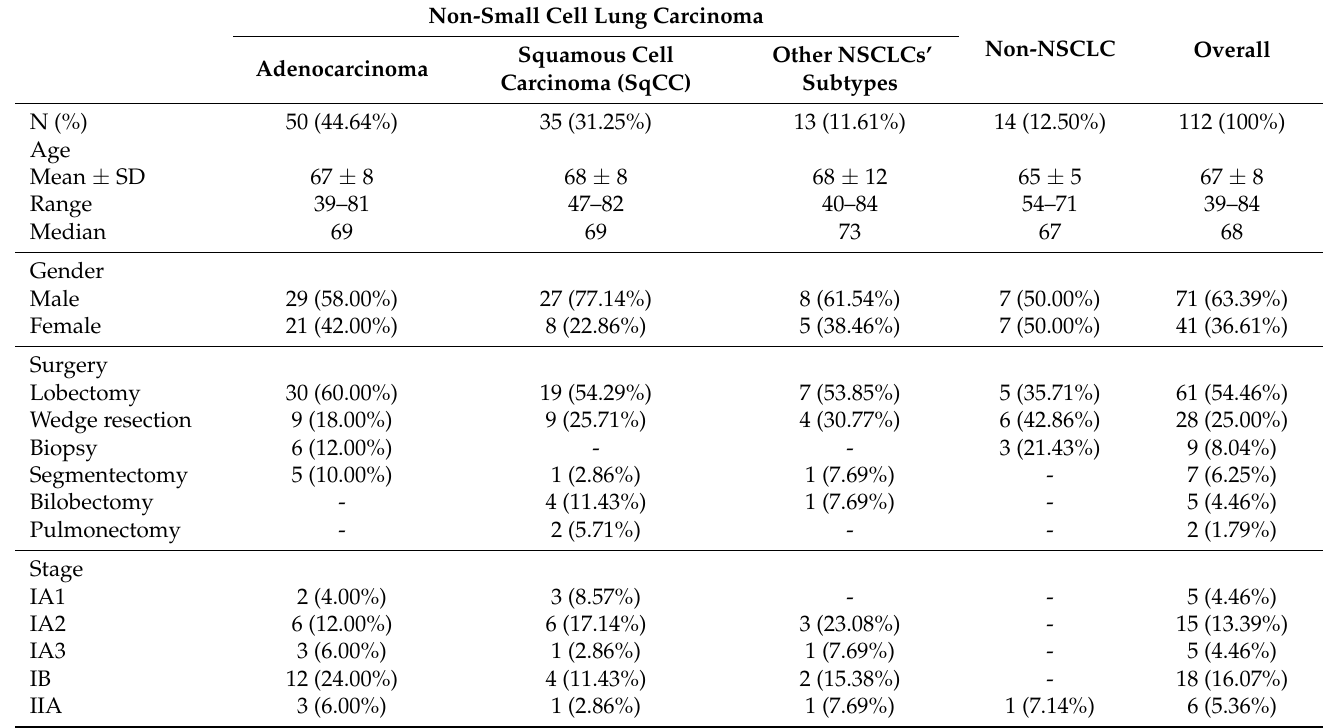
Table 1. Patients’ characteristics according to the type of lung